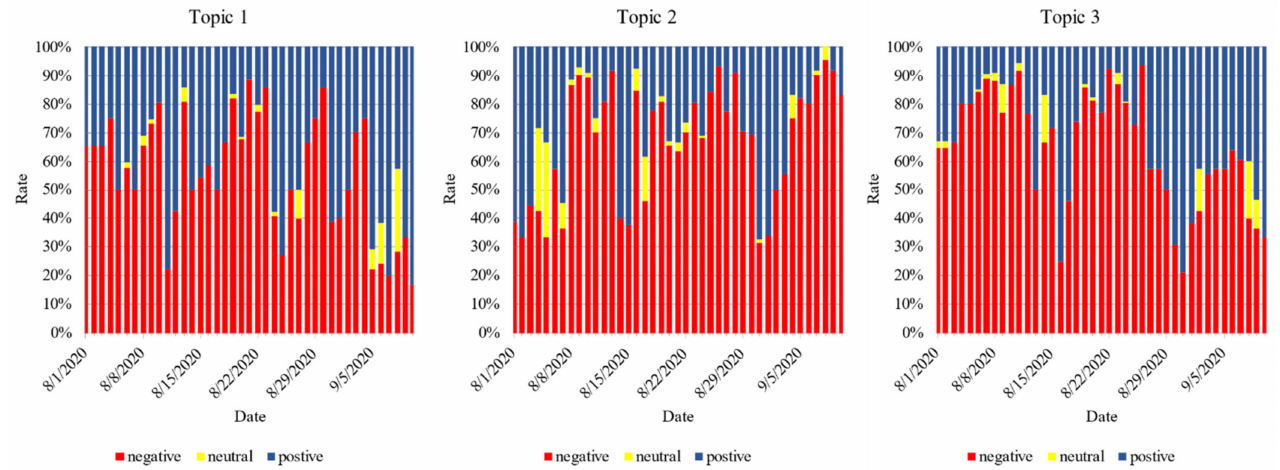
Figure 10. Relative frequencies of attitude tendencies in topics over